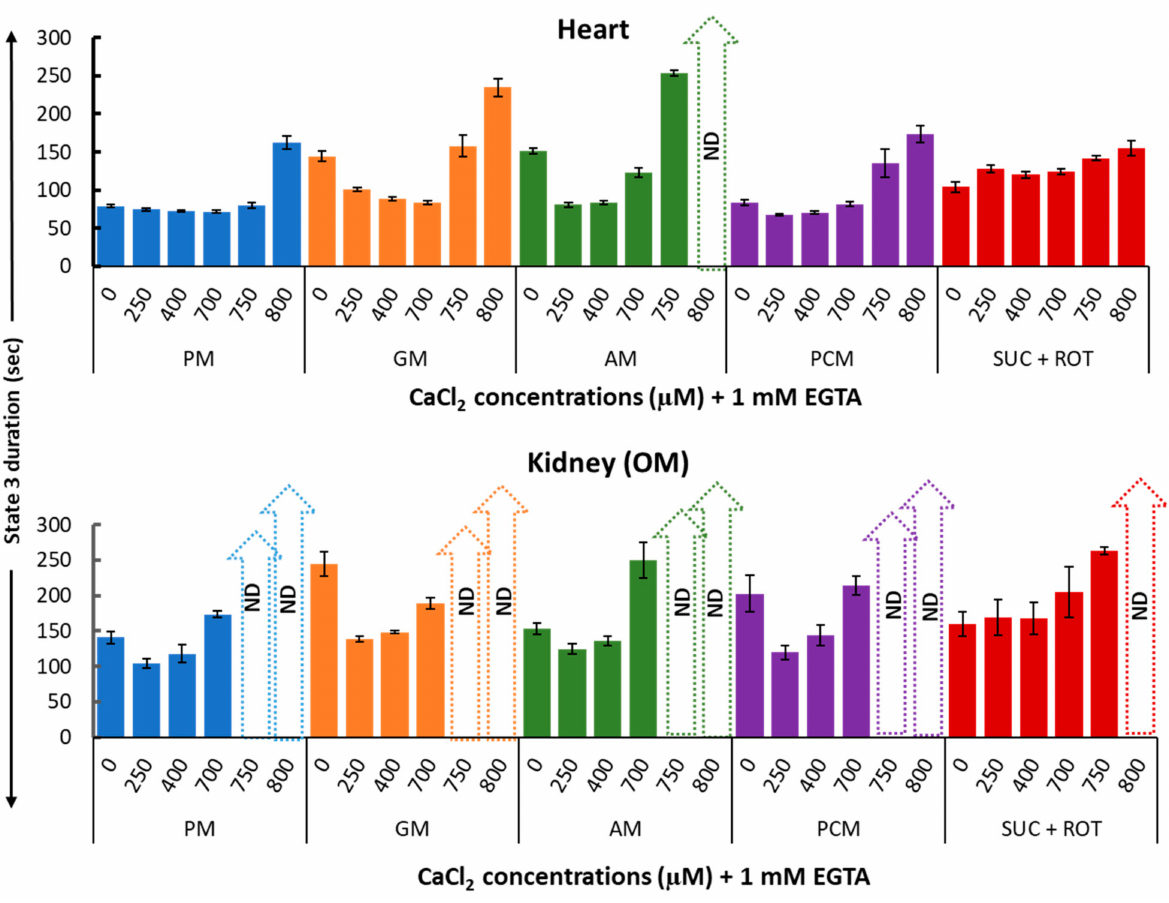
Figure 7. Summary of the different respiratory substrate-dependent effects of Ca 2+ on the heart (upper panel) and kidney OM (lower panel) mitochondrial state 3 duration of OCR. The X-axis shows CaCl 2 added to the buffer in the presence of 1 mM Ca 2+ chelator EGTA. Each bar plot represents the mean value ± SEM ( n = 4–6) of state 3 durations of OCR. ND: not